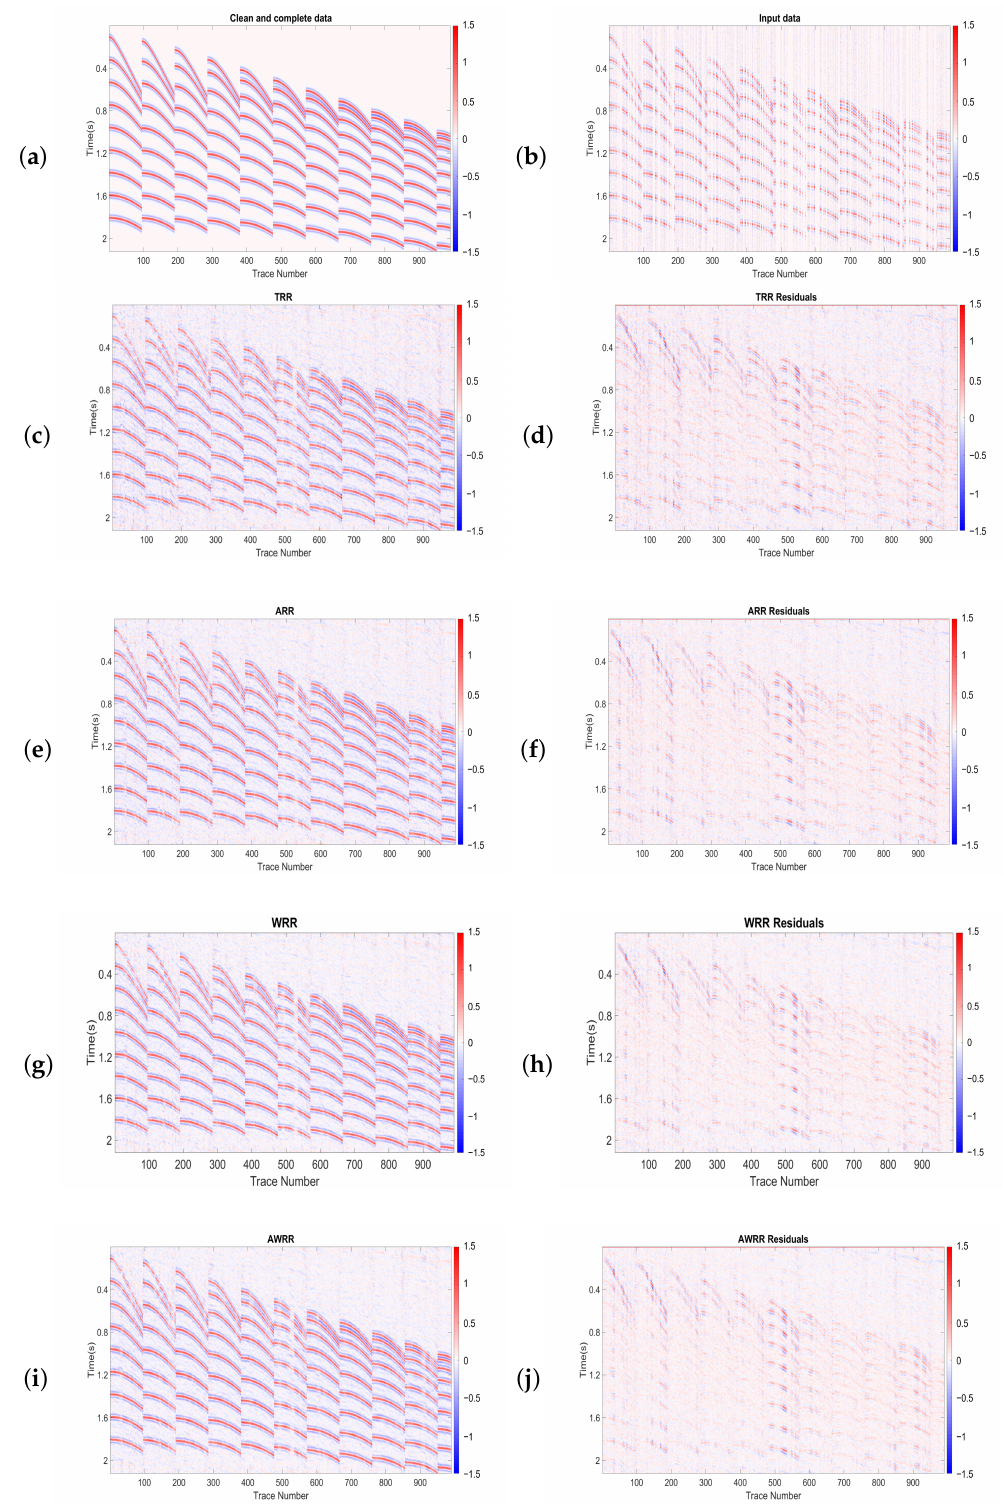
Figure 11. Comparison of different methods of rank-reduction. ( a ) Clean and complete data, ( b ) input data with SNR = 2 and 60% missing traces; ( c , e , g , i ) data interpolated by TRR, ARR, WRR, and AWRR, respectively; ( d , f , h , j ) residual errors of TRR, ARR, WRR, and AWRR,